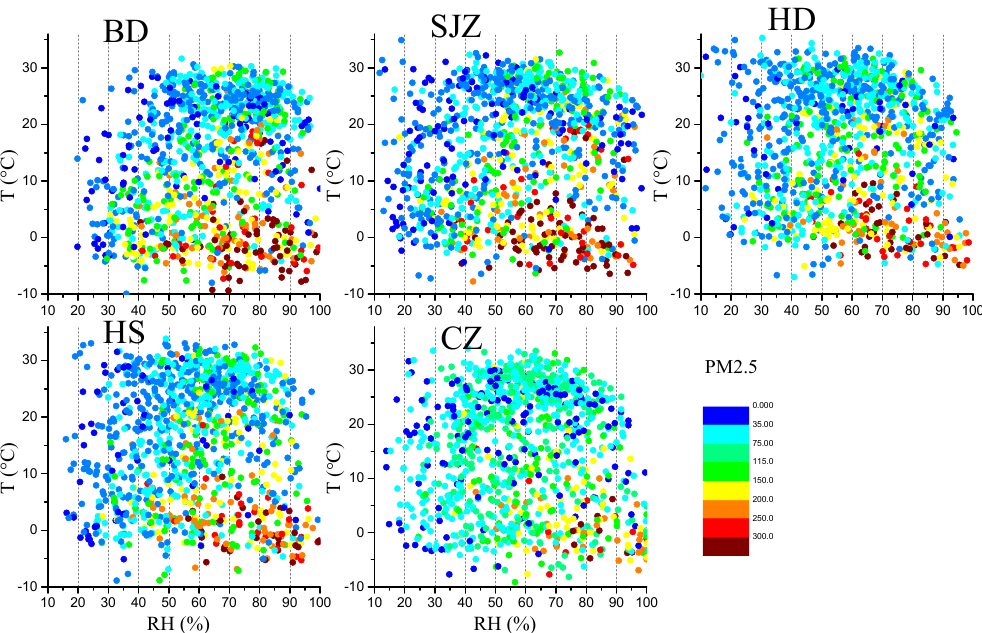
Figure 7. The relationship among T, RH, and PM 2.5 concentrations in five cities during 2013–2015.